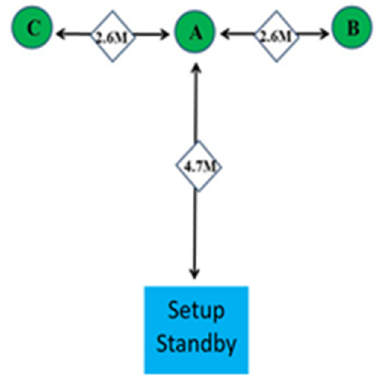
Figure 3. Agility t -test venue layout.